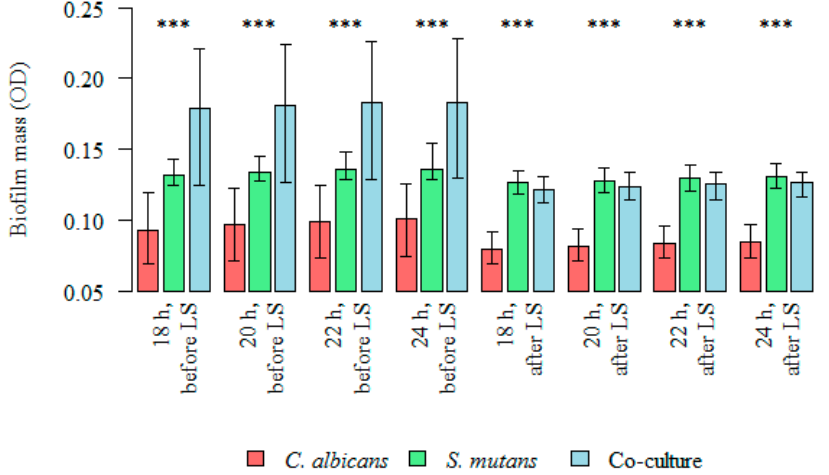
Figure 4. Intergroup differences between biofilm mass (OD), before and after Lactobacillus salivarius (HM6 Paradens, LS) administration. Kruskal–Wallis test was used for dependent (repeated) measurements; p < 0.05; *** Dunn’s test (post-hoc test).